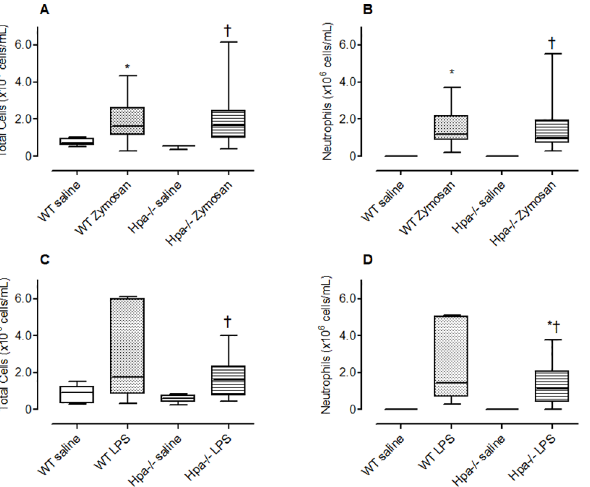
Fig 2. The effect of genetic modification of heparanase on neutrophil recruitment to the lung. The total number of inflammatory cells (A, C) and neutrophils (B, D) recruited to the lung following acute exposure of wild-type (WT), and Hpa -/- mice to intranasal (i.n.) saline, zymosan (A, B) or LPS (C, D). Data presented as box plots (median, 25 – 75 percentile) with whiskers representing 5 – 95% confidence interval. The number of animals represented by box plots in each panel is as follows; Panel A, B: Saline treated group (WT; n = nil ♀ , 5 ♂ ; Hpa -/- , n = 2 ♀ , 1 ♂ ) and zymosan treated group (WT; n = 4 ♀ , 4 ♂ ; Hpa -/- , n = 3 ♀ , 4 ♂ ). * p < 0.05 compared with saline; † No significant difference compared with WT zymosan. Panel C, D: Saline treated group (WT: wild type; n = 2 ♀ , 3 ♂ ; Hpa -/- , n = 3 ♀ ) and LPS treated group (WT; n = 5 ♀ ; Hpa -/- , n = 4 ♀ ). * p < 0.05 compared with saline; † No significant difference compared with WT LPS. Data obtained from one experiment.